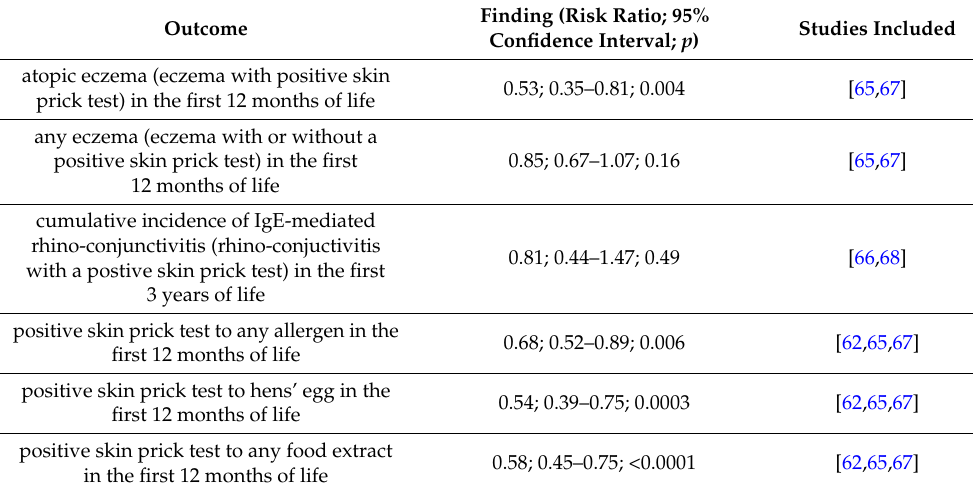
Table 2. Summary of the findings of the meta-analysis of Best et al. [76] of randomized controlled trials of n -3 PUFAs in pregnancy reporting on allergic outcomes in the offspring. Finding (Risk Ratio; 95% Studies Outcome Confidence Interval; p )